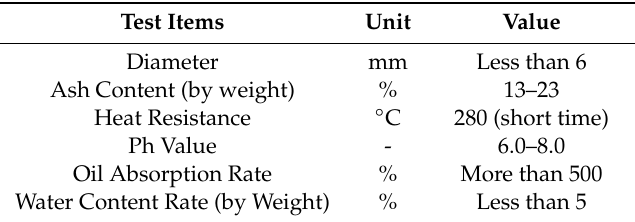
Table 1. Properties of GL and FL.